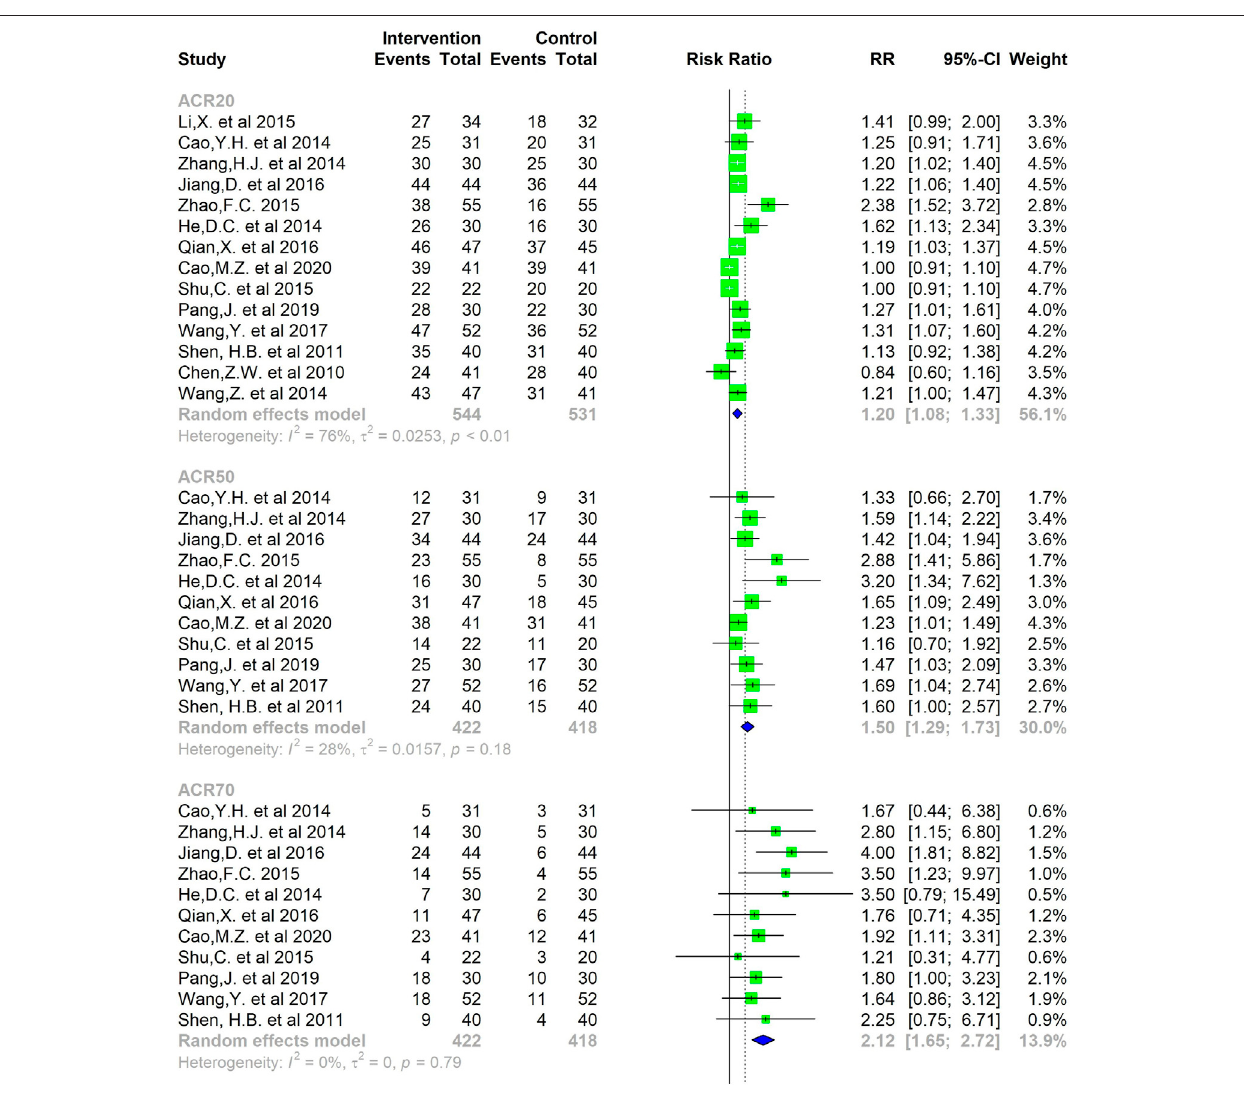
Frontiers in Pharmacology |